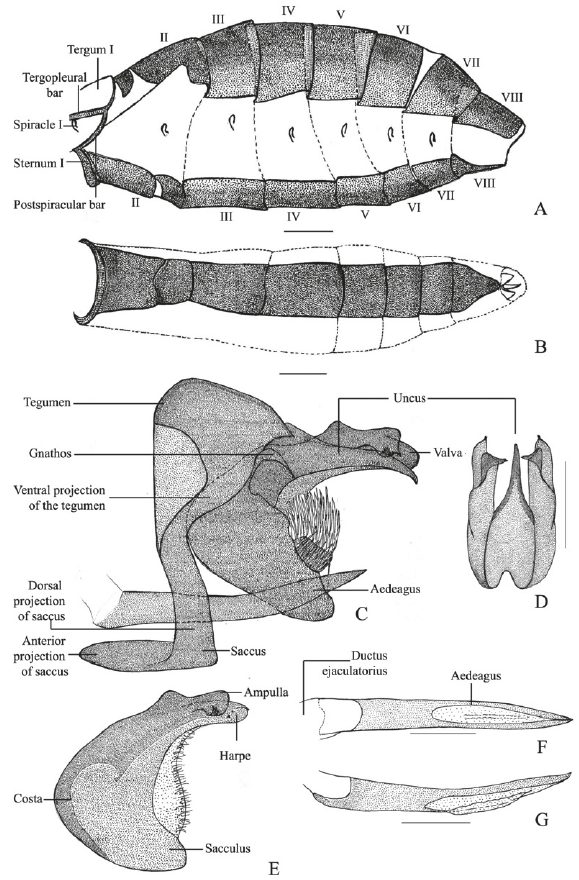
Figure 14. Male genitalia of Junonia hierta (Fabricius, 1798) A – B - abdomen (dorsal and ventral view, respectively); C - male genitalia (lateral view); D - uncus (dorsal view); E - right valva (inner view); F – G - aedeagus (dorsal and lateral view respectively). Scale bar 1mm.